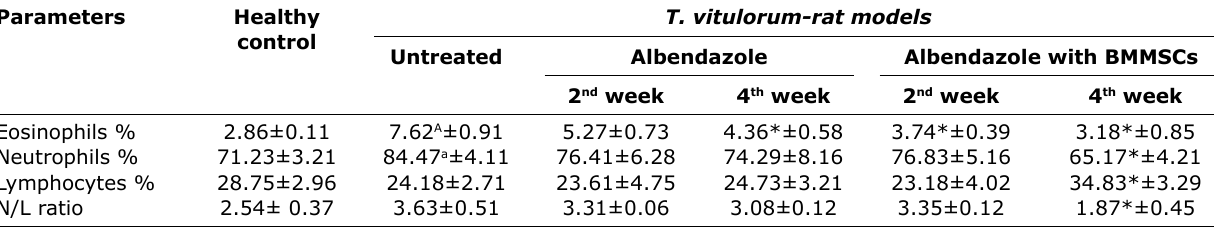
Mean±SE. Values having letter a are significantly different than corresponding healthy control at p<0.05. Values having * are significantly different than corresponding untreated at p<0.05. BMMSCs=Bone marrow mesenchymal stem cells,